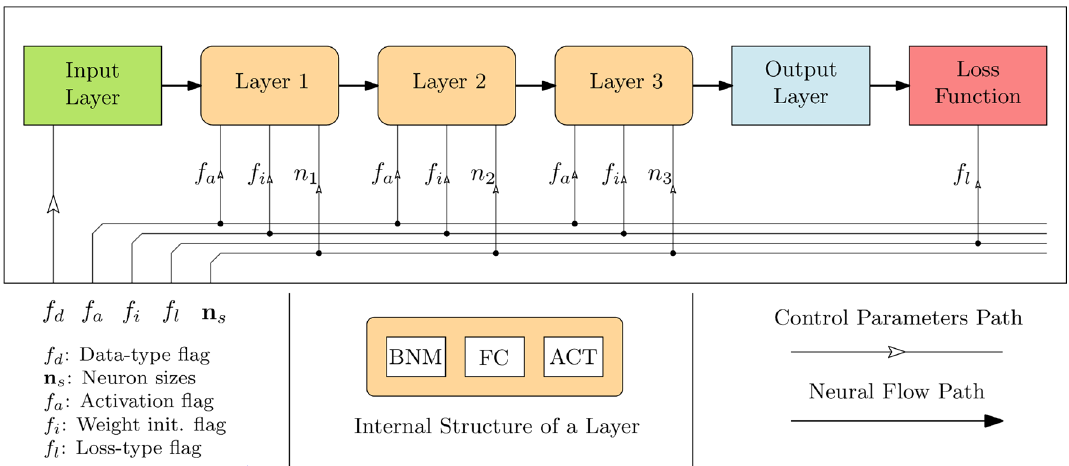
Figure 1. General architecture of the FARM model. The user only defines the number of hidden layers (set to three in the considered example). Subsequently, the optimum setup of parameters, pre-processing type, and the loss function for model training, are all determined by